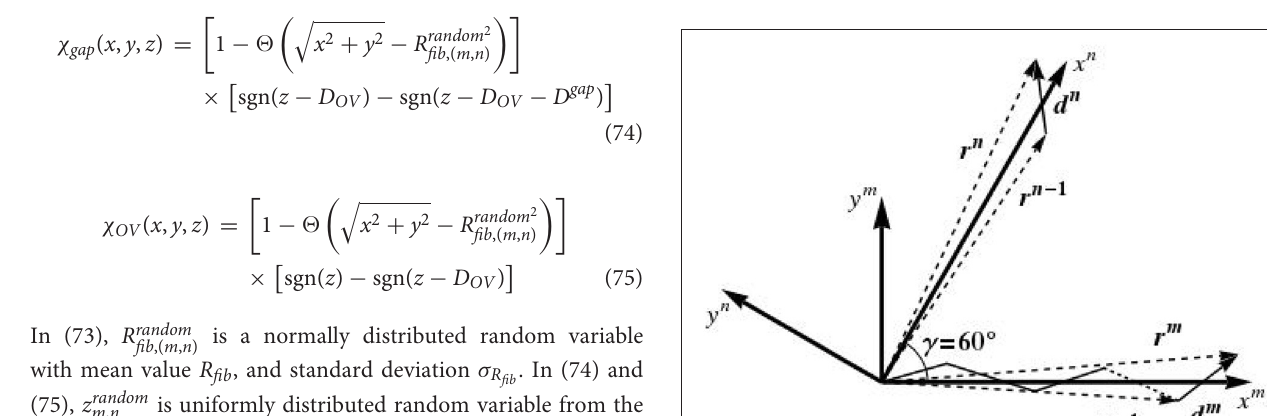
is the correlation coefficient between d x and d y , with . denoting the average over all points h i of the 1D paracrystalline lattice. Characteristics of the paracrystal are controlled by the parameters σ x , σ y , and ρ . d x and d y are uncorrelated, so that ρ 0. The standard deviations σ x and σ y = are equal and defined as